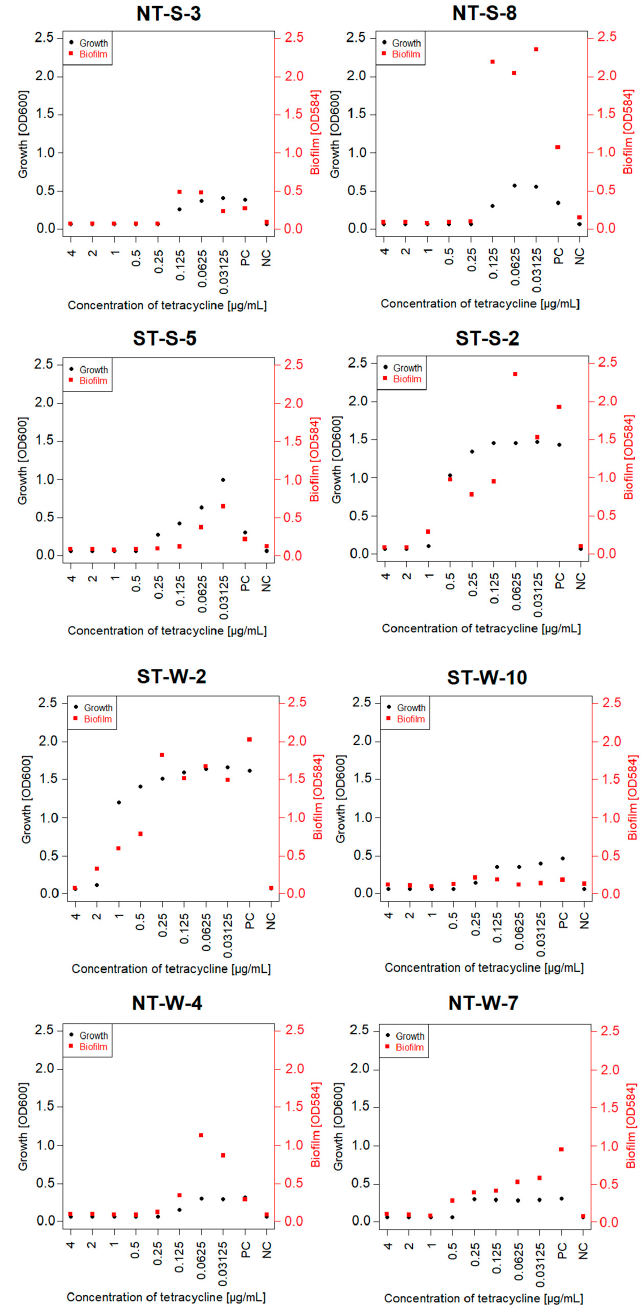
Figure 6. Effect of different concentrations of tetracycline (µg/mL) on bacterial growth (optical density measured at 600 nm) and bacterial biofilm formation (determined with crystal violet assay measured at 584 nm) of selected isolates after 24-h incubation at 30 °C from nitrification tank (NT) and sedimentation tank (ST) of wastewater treatment plant. PC positive control (inoculum without tetracycline); NC negative control (TSB).